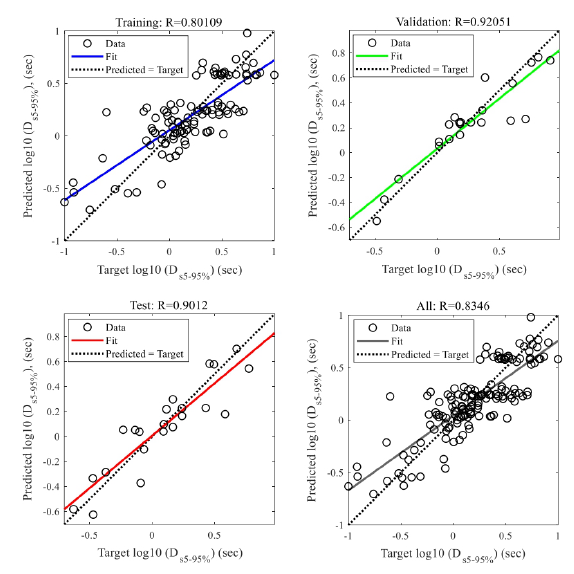
Fig. 6. Comparison of target (actual) data with the predicted data of log 10 D s 5 − 95%